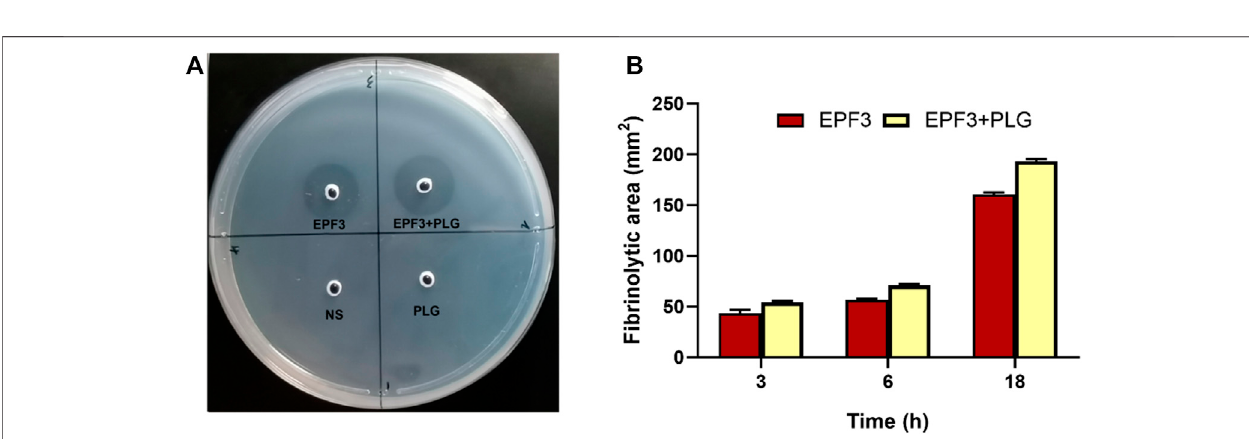
Frontiers in Molecular Biosciences |